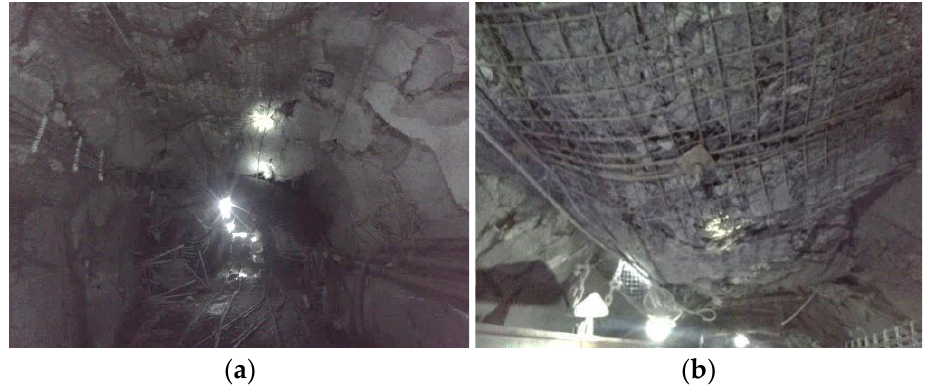
Figure 4. Deformation diagram of partial roadway-surrounding rock. ( a ) Overall damage diagram ( b ) Local damage diagram